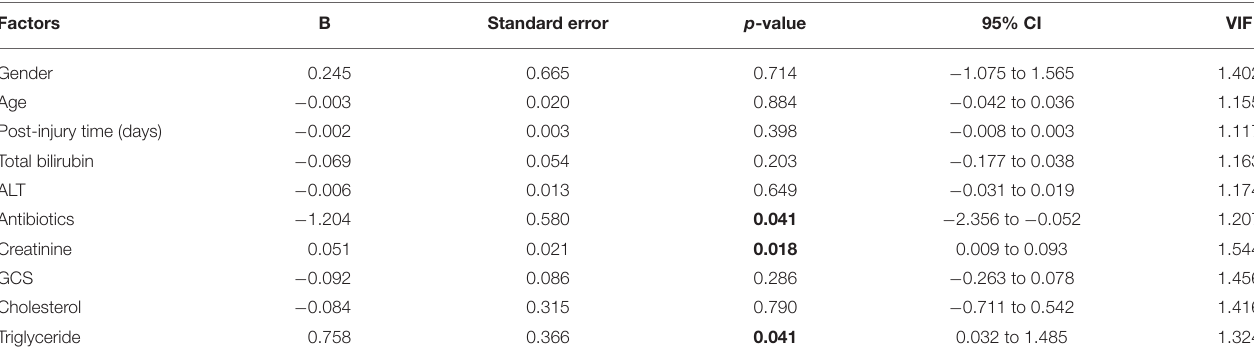
TABLE 4 | Linear regression analysis for serum bile acid level of TBI